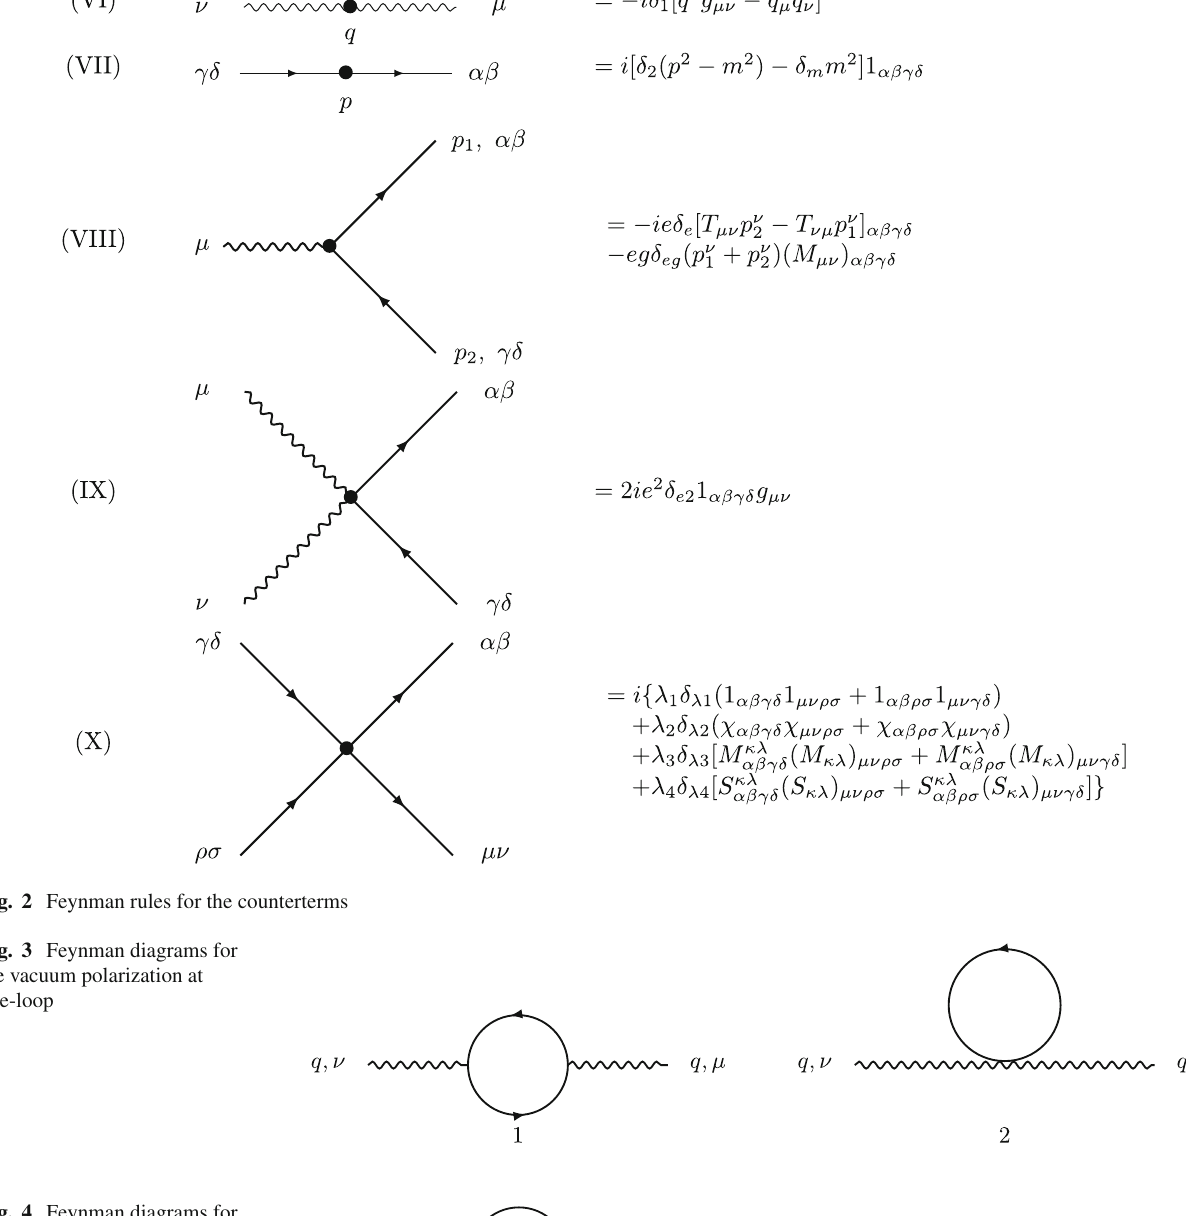
Fig. 4 Feynman diagrams for the Tensor self-energy at